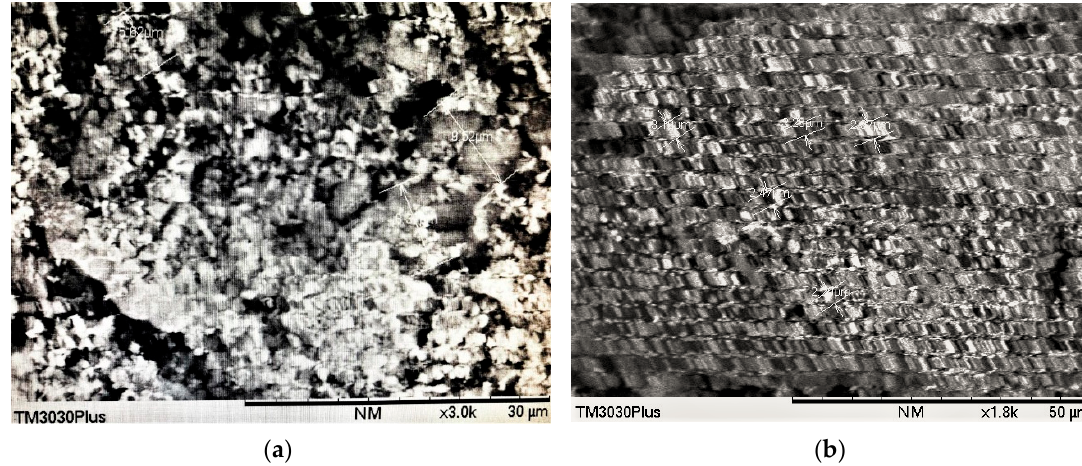
Figure 14. SEM diagrams of the optimized catalyst: ( a ) Chitin/ZnO = 2:3, calcinated at 400°C and ( b ) Chitin/ZnO = 2:3, calcinated at 500 °C. (Testing by TM3030plus.)